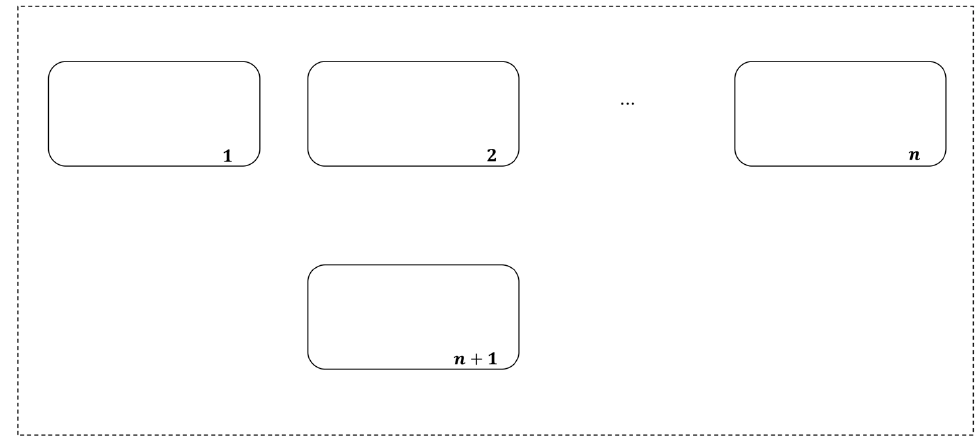
Figure 2. The initial configuration of the tissue—like P system.